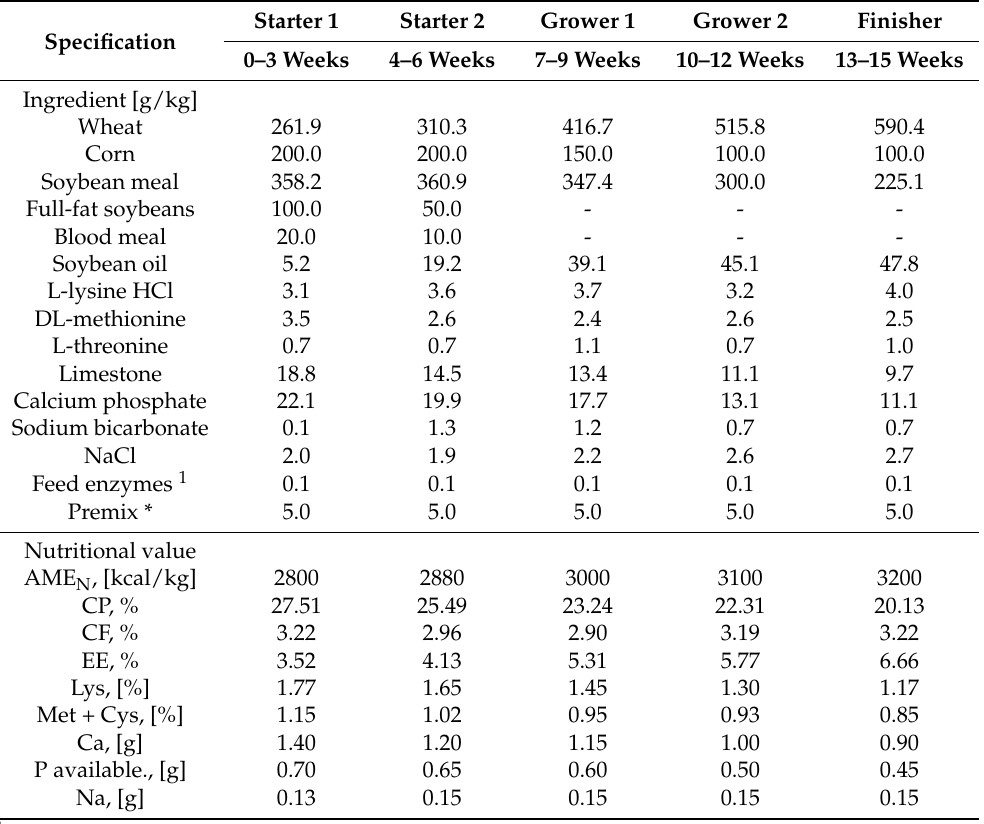
Table 1. Composition of the basal diets and the calculated nutritional